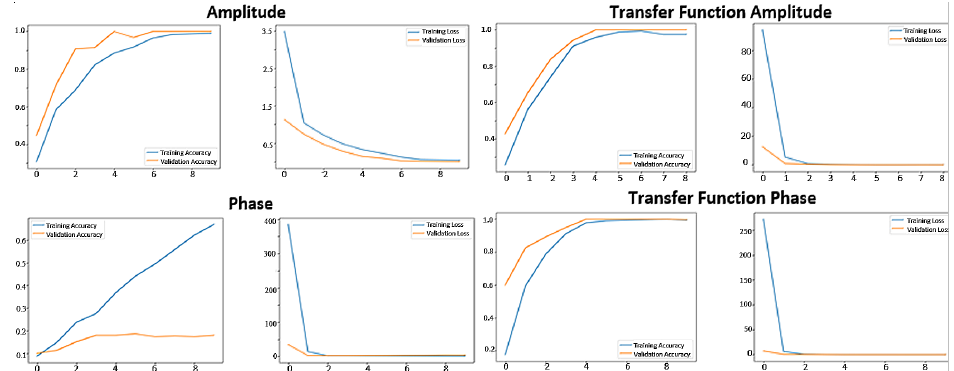
Figure 15. The accuracy and loss for each model over each training epoch. All models are capable of learning the difference in the 9 labels except for the phase model.